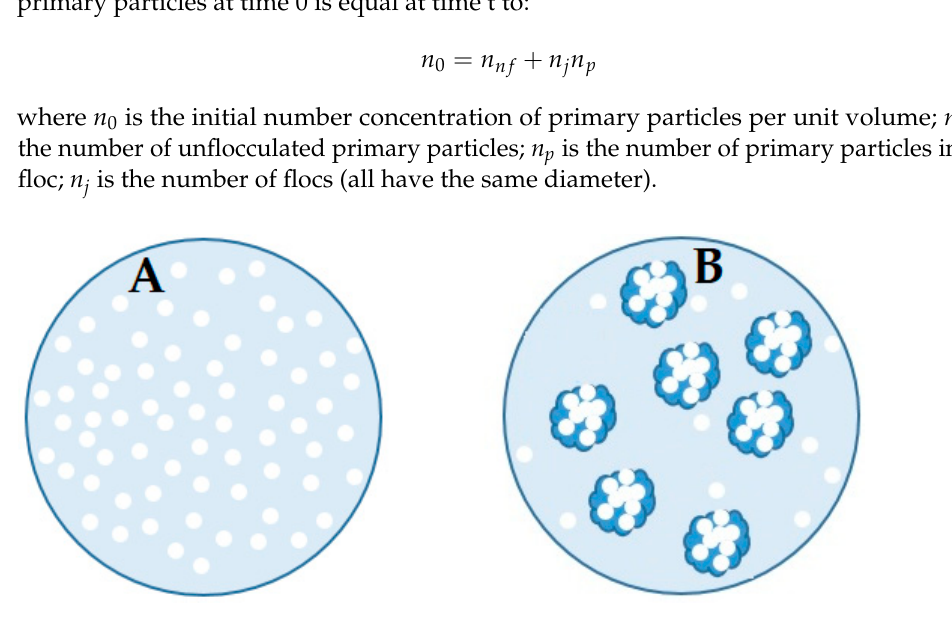
Figure 2. Illustration of the decrease of the number of free primary particles before ( A ) and during flocculation ( B ).